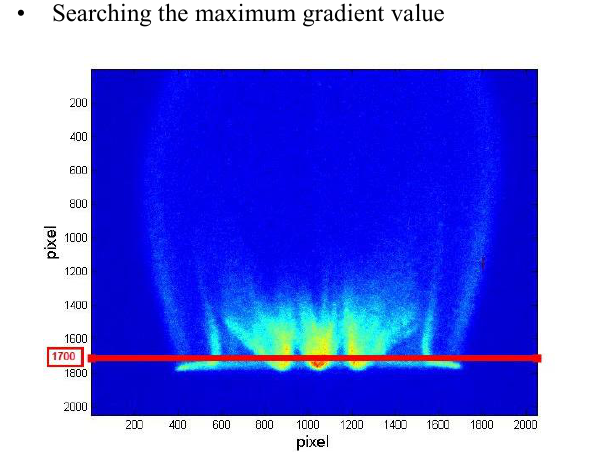
Fig. 4. Position of signal cross-section , highlighted by red line Selection of the cross-sectional position was based on observation. The Fig. 4 shows that the position of the cross section could include maximal gradient